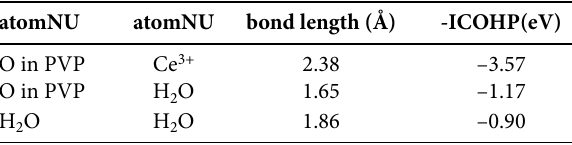
Table 1. The bond length and ICOHP value between each atom af- ter the optimization before precipitation is completed